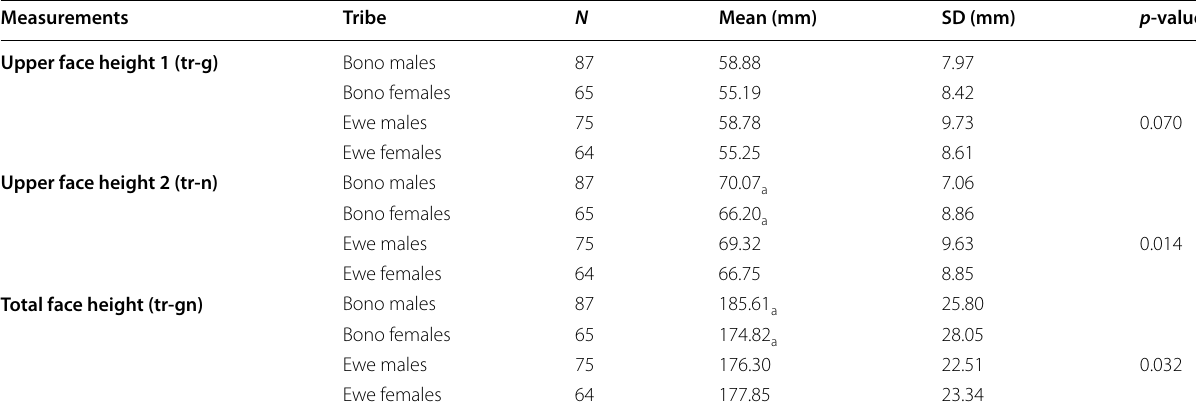
N number of participants, SD standard deviation, tr-g trichion to glabella, tr-n trichion to nasion, tr-gn trichion to gnathion, mm millimetre. a letters have differences existing between the mean values of two tribes by means of a post hoc test (the p values are only the result of the ANOVA and not the post hoc test). Statistical significance at p < 0.05